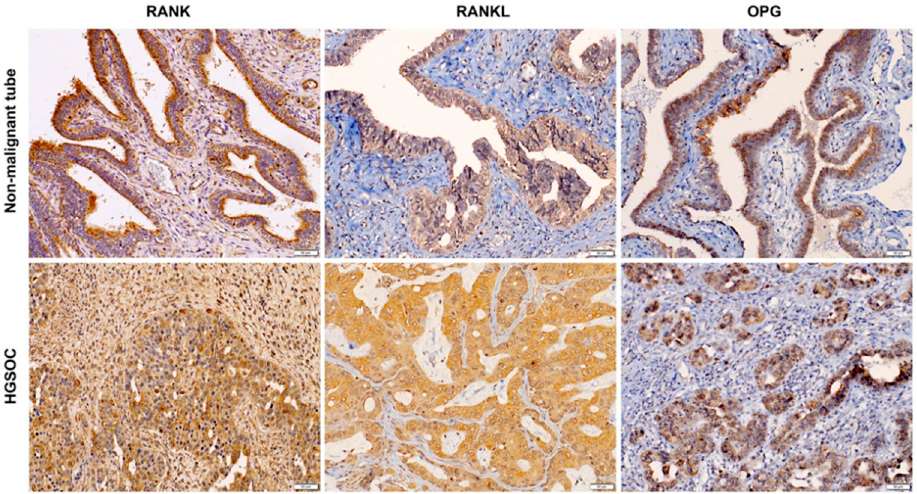
Figure 4. RANK, RANKL and OPG localize to cancer cells and tumour microenvironment in OC. Representative RANK, RANKL and OPG immunohistochemistry on FFPE sections from non-malignant tubes and HGSOC. n = 8–10 (per target); Scale bars indicate 50 µm.